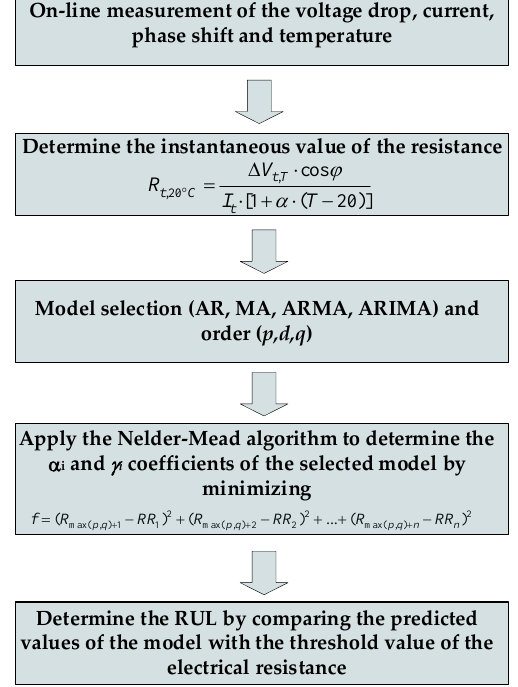
Figure 3. Flux diagram illustrating the key steps of the proposed approach to determine the RUL.